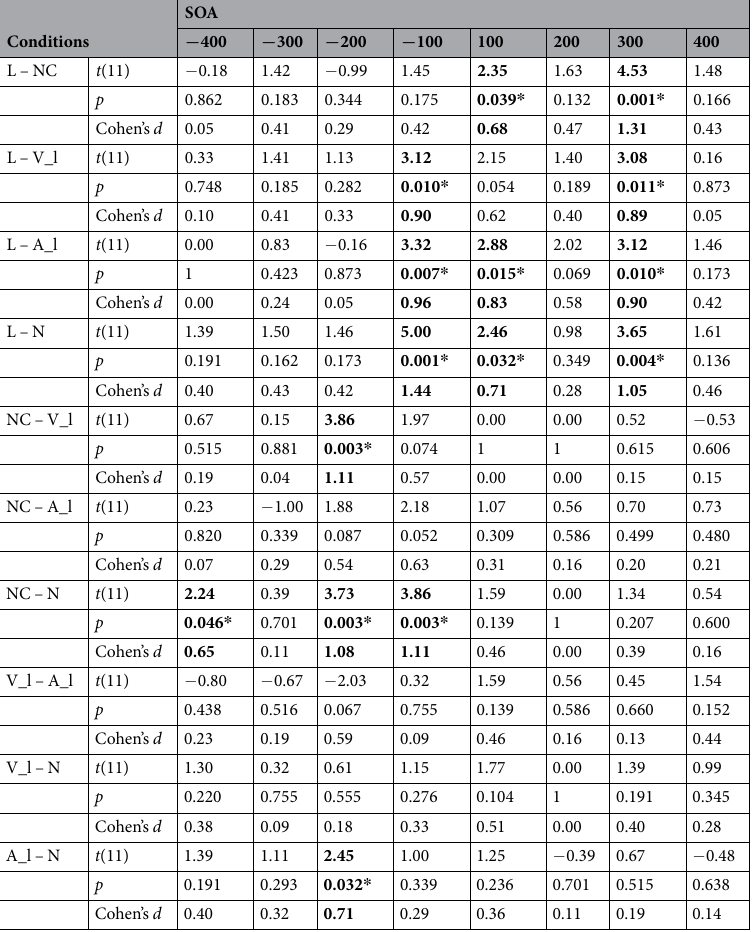
Table 1. Results of two-tailed t-tests for all conditions and SOAs. Note. SOA = stimulus onset asynchrony (negative values = auditory stimulus first, positive values = visual stimulus first); L = audio-visual learned; NC = audio-visual newly combined; V-l = audio-visual visual_learned; A-l = audio-visual auditory_learned; N = audio-visual new. * p < 0.05 (values of significant pairwise comparisons are in